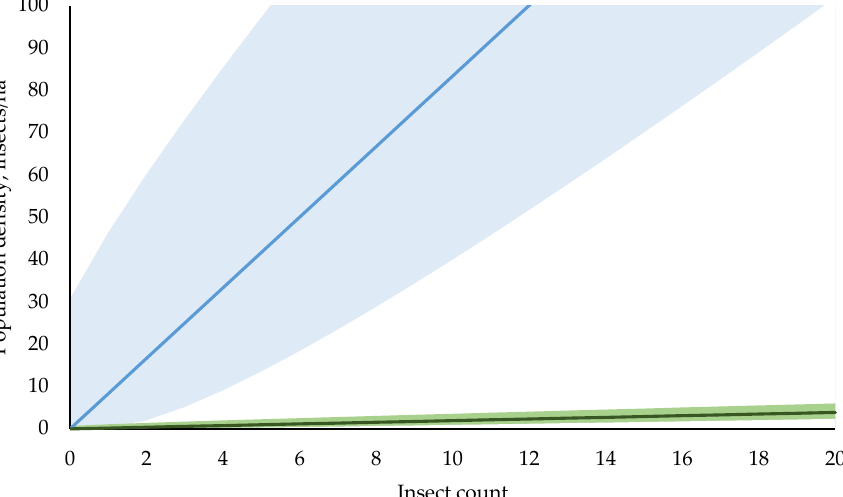
Figure 3. Absolute population densities as a function of catch (insect count M) in baited traps for codling moth (blue) and European sawfly (green). Light blue and green areas indicate the ranges between lower and upper bounds with 95% confidence for codling moth and European sawfly, respectively. Dark lines in the middle indicate the most probable average densities ρ mp . For the same number of insects caught, the corresponding population densities differ by nearly two orders of magnitude.